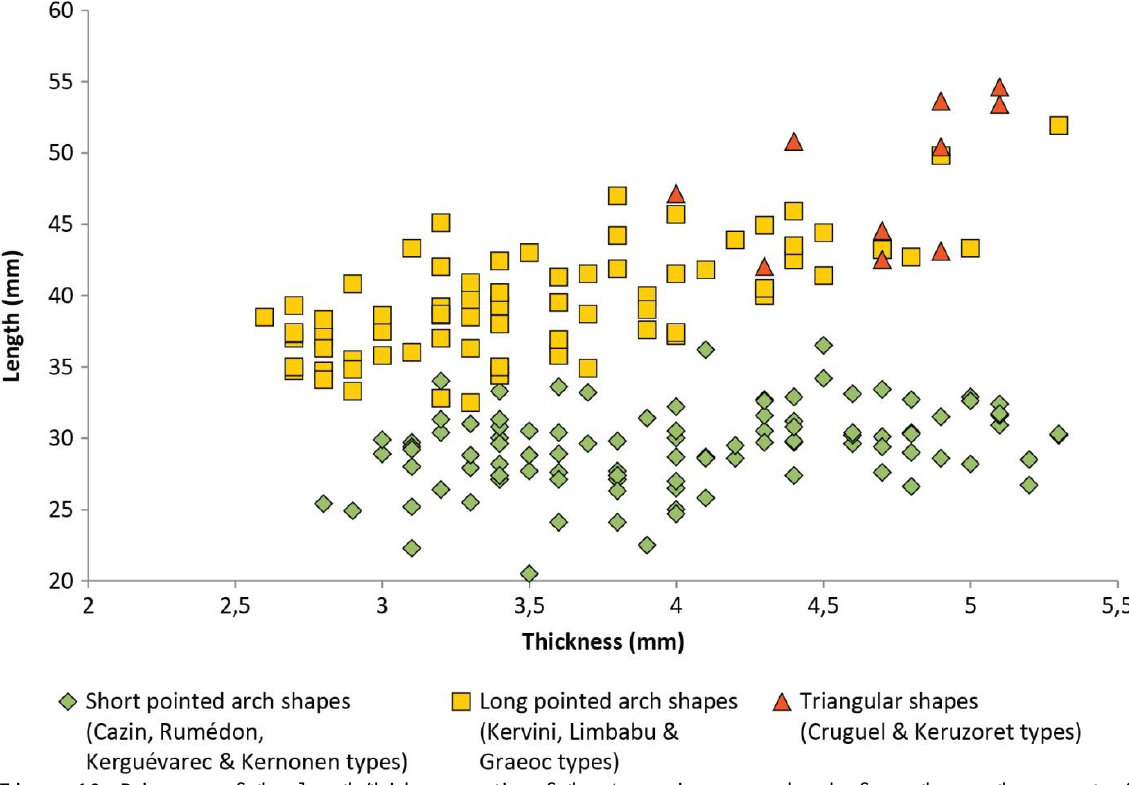
Figure 10. Diagram of the length/thickness ratio of the Armorican arrowheads from the northern part of